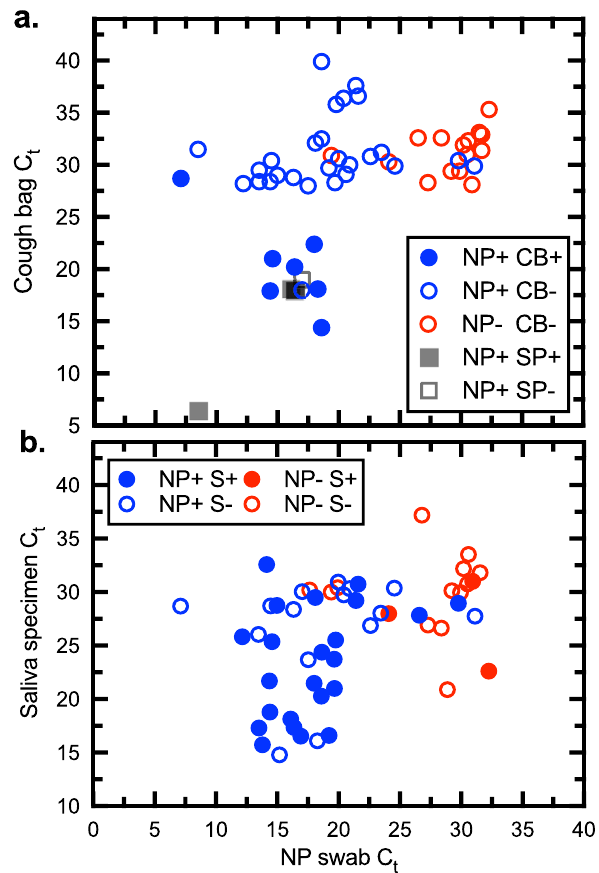
Figure 6. Infectious SARS-CoV-2 in saliva, sputum, and cough specimens. ( a ) Virus samples were acquired from NP swabs as well as cough bag samples (CB), sputum (SP), or saliva (S). Samples determined to contain infectious virus are indicated with solid-colour coding. ( b ) Virus samples were acquired from NP swabs as well as saliva. A C t ≤ 25 in the NP swab predicts that about 1/3–1/2 of the cough/sputum and saliva specimens will also bear infectious virus, respectively. Figure prepared using Prism v9.3 (https:// www. graph pad.